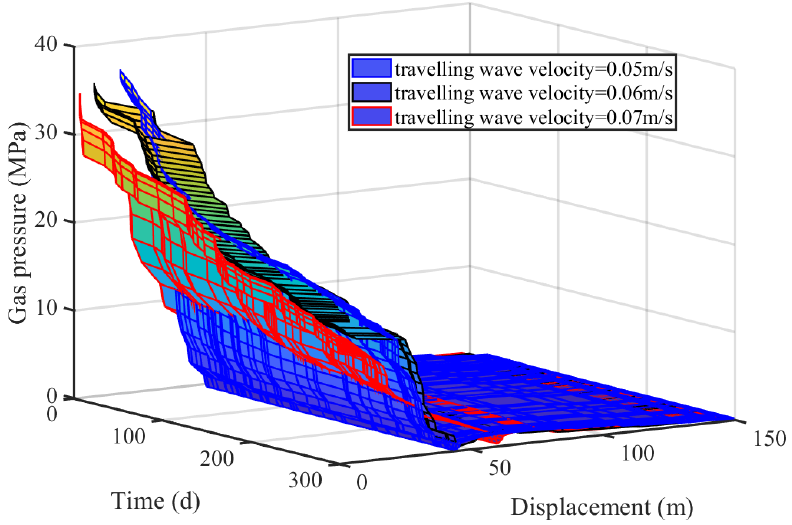
Figure 6. Impact of the traveling wave velocity on gas pressure.